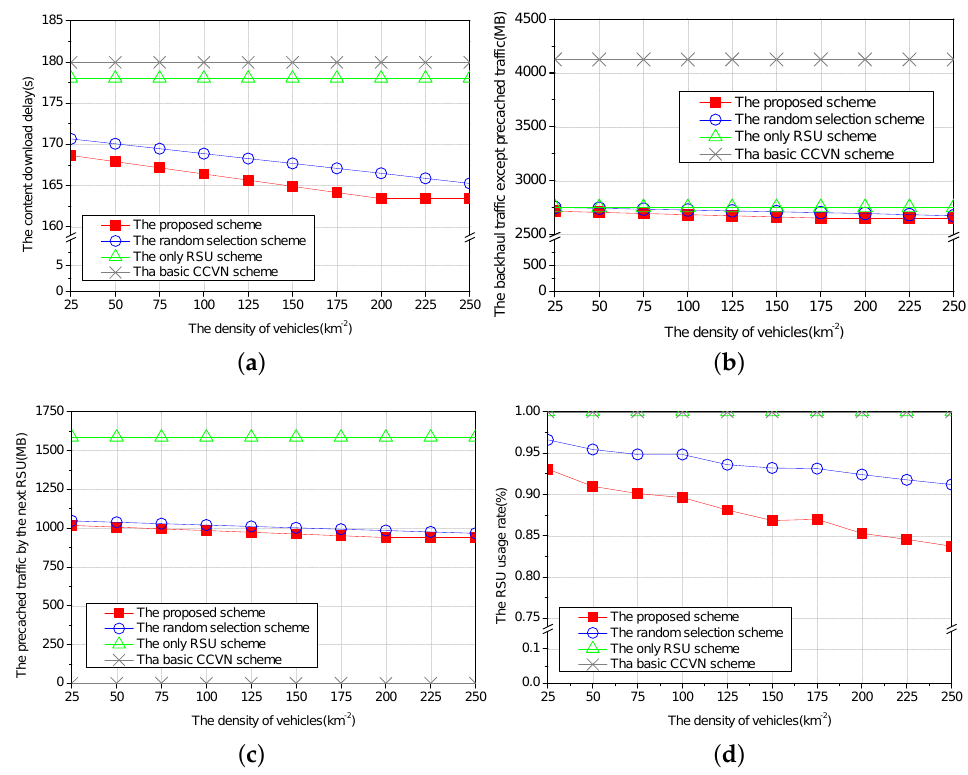
Figure 2. Simulation results for different densities of vehicles: ( a ) the content download delay, ( b ) the backhaul traffic except precached traffic, ( c ) the precached traffic by next RSU and ( d ) the RSU usage